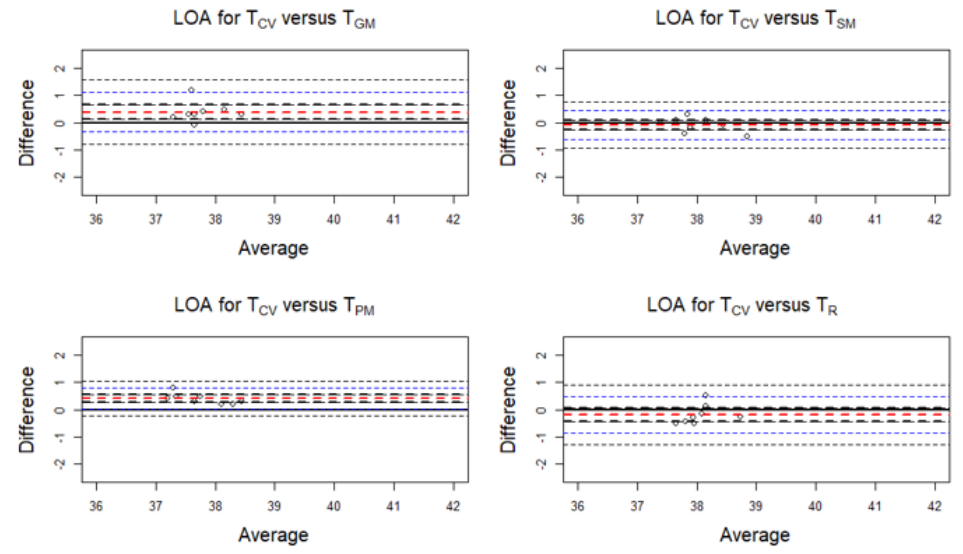
Figure 4. Limits of agreement (LOA) plots for the temperature pairs (T CV / T GM , T CV / T SM , T CV / T PM , and T CV / T R ) during Phase A (prior to exercise). The red horizontal dashed line indicates the mean bias. The blue horizontal dashed lines indicate the upper and lower limits. The black horizontal dashed lines indicate the 95% confidence intervals of the LOA. T CV = central venous temperature, T PM = pectoral muscle temperature, T GM = gluteal muscle temperature, T SM = splenius muscle temperature, T R = rectal temperature.